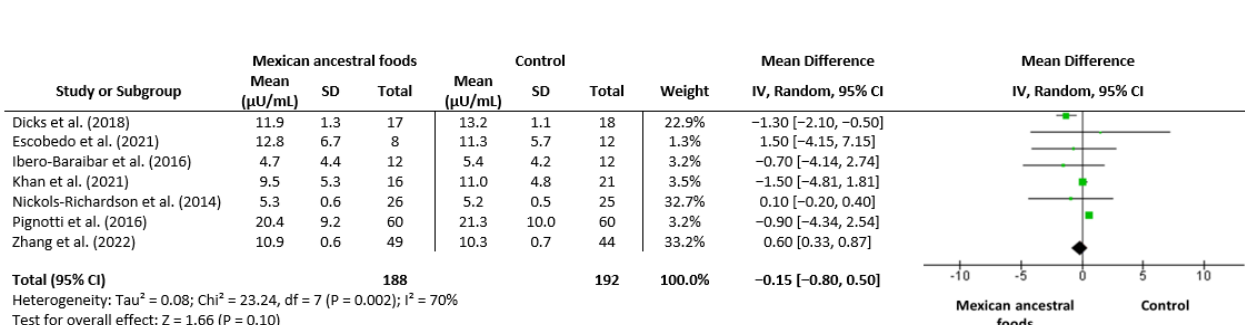
Figure 6. Effect of Mexican ancestral foods supplementation on ( A ) Fasting plasma glucose [29,31 – 35,37,39,41 – 43] , ( B ) HOMA-IR [29,31,34,35,37,39,41,43] and ( C ) Insulin [29,31,34,37,39,41,43] . All data are presented as mean ± standard deviation and confidence interval is 95% (CI). Study weights were assigned using the inverse variance method and random-effects model. The diamond ) represents ( ) represents the overall effect estimate of the meta-analysis and the green point ( ) represents mean difference of effect measure of each study.